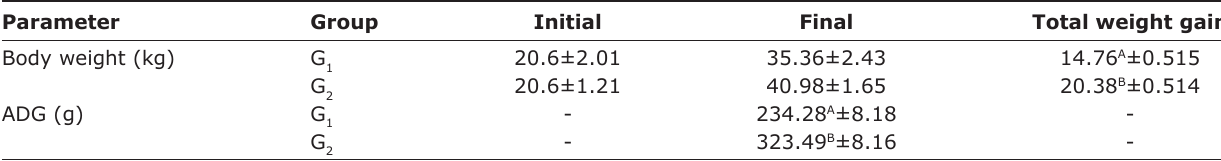
Table-1: Mean±SE of body weight (kg) changes and ADG (g) of Vrindavani calves. Parameter Group Initial